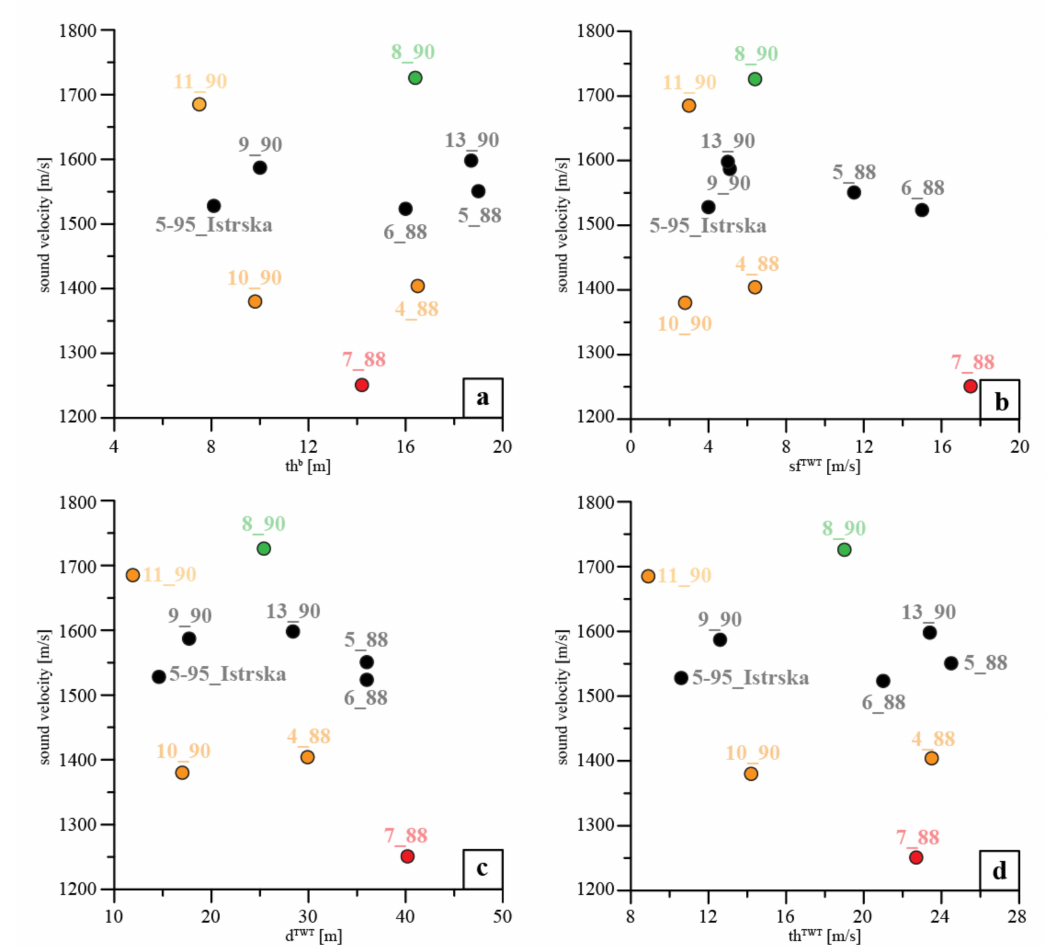
Figure 6. Plots of sound velocity versus ( a ) the thickness of Quaternary sediments (taken from borehole logs), ( b ) the depth of the seafloor (taken from sonar profiles), ( c ) the depth of the top of the bedrock (taken from sonar profiles), and ( d ) the thickness of Quaternary sediments (taken from sonar profiles). For clarity, A-III- and V- prefixes are removed from borehole labels. Data points in orange mark less reliable velocities (boreholes more than 5 m away from the nearest sub-bottom sonar profile; Table 2 and Figure 2b). Data points in green and red mark the maximum and minimum calculated